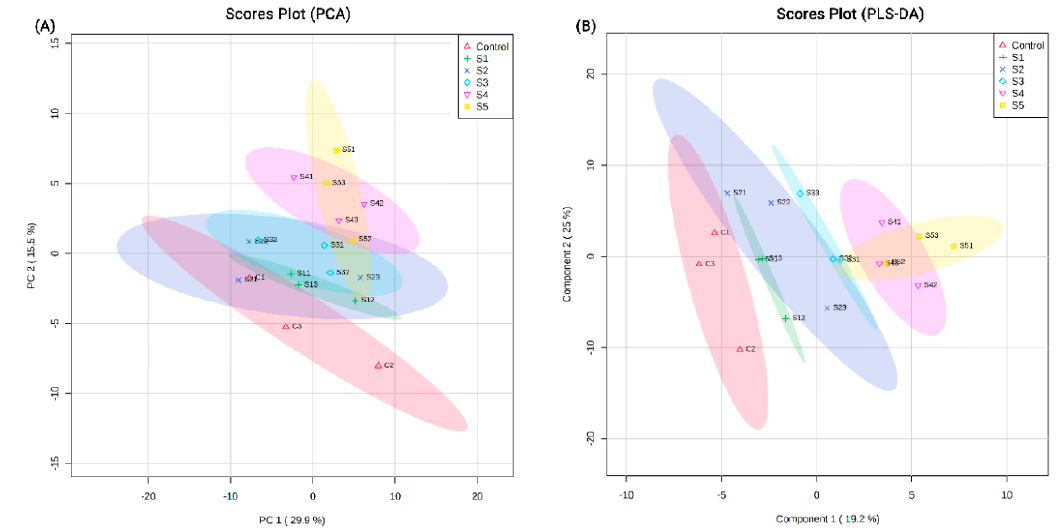
Figure 2. ( A ) PCA plots and ( B ) PLS-DA plots generated by MetaboAnalyst showing the clustering of the 1089 identified proteins across the different experimental groups. C indicates control. S1–S5 indicate dietary groups treated with 0.1%, 0.25%, 0.5%, 0.75% and 1.0% dry diet weight of 24-methylenecholesterol respectively. Numbers 1–3 for every group indicate the replicate cage number.